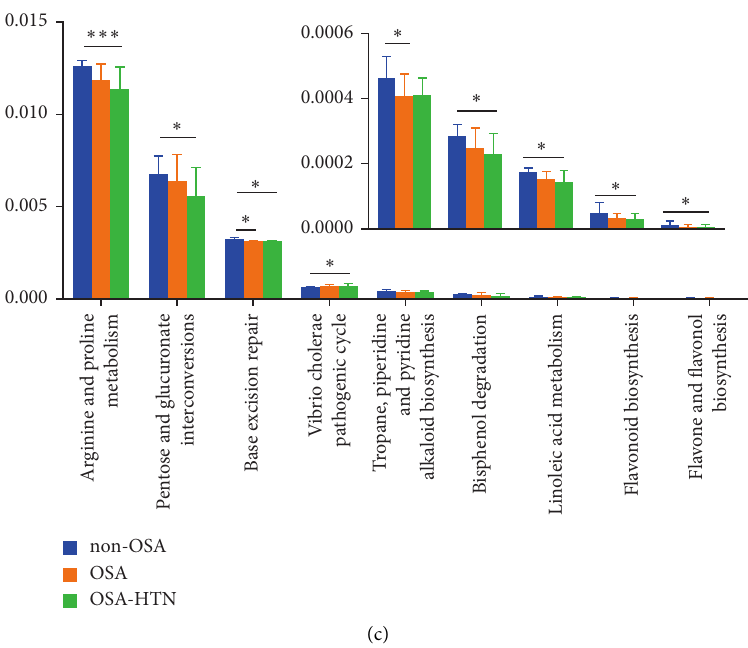
Figure 1: Alteration of the gut microbiome in severe obstructive sleep apnea (OSA) patients with hypertension and those without hy- pertension. (a) The Firmicutes to Bacteroidetes ratio is similar across groups at the phylum level. (b) The Kruskal–Wallis test was used to analyze differences in the relative abundance of the fecal microbiota at the genera level. (c) Predictive functional analysis revealed that the fecal microbiome exhibited significant Kyoto Encyclopedia of Genes and Genomes pathways. Statistical analysis was performed with the Kruskal–Wallis test. Non-OSA: apnea-hypopnea index (AHI) ≤ 5 without hypertension, OSA: severe OSA (AHI ≥ 30) without hypertension, and OSA-HTN: severe OSA with hypertension. ∗ P < 0 . 05, ∗∗ P < 0 . 01, and ∗∗∗ P < 0 . 001 compared with the non-OSA group or the OSA